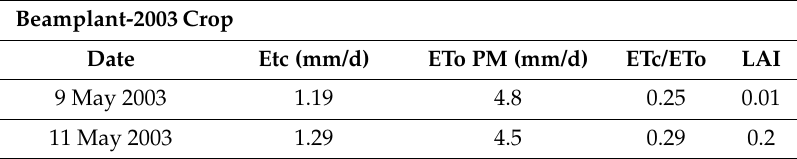
Table 2. Details of the National Research Council (CNR) scientific agrarian dataset. LAI—leaf area